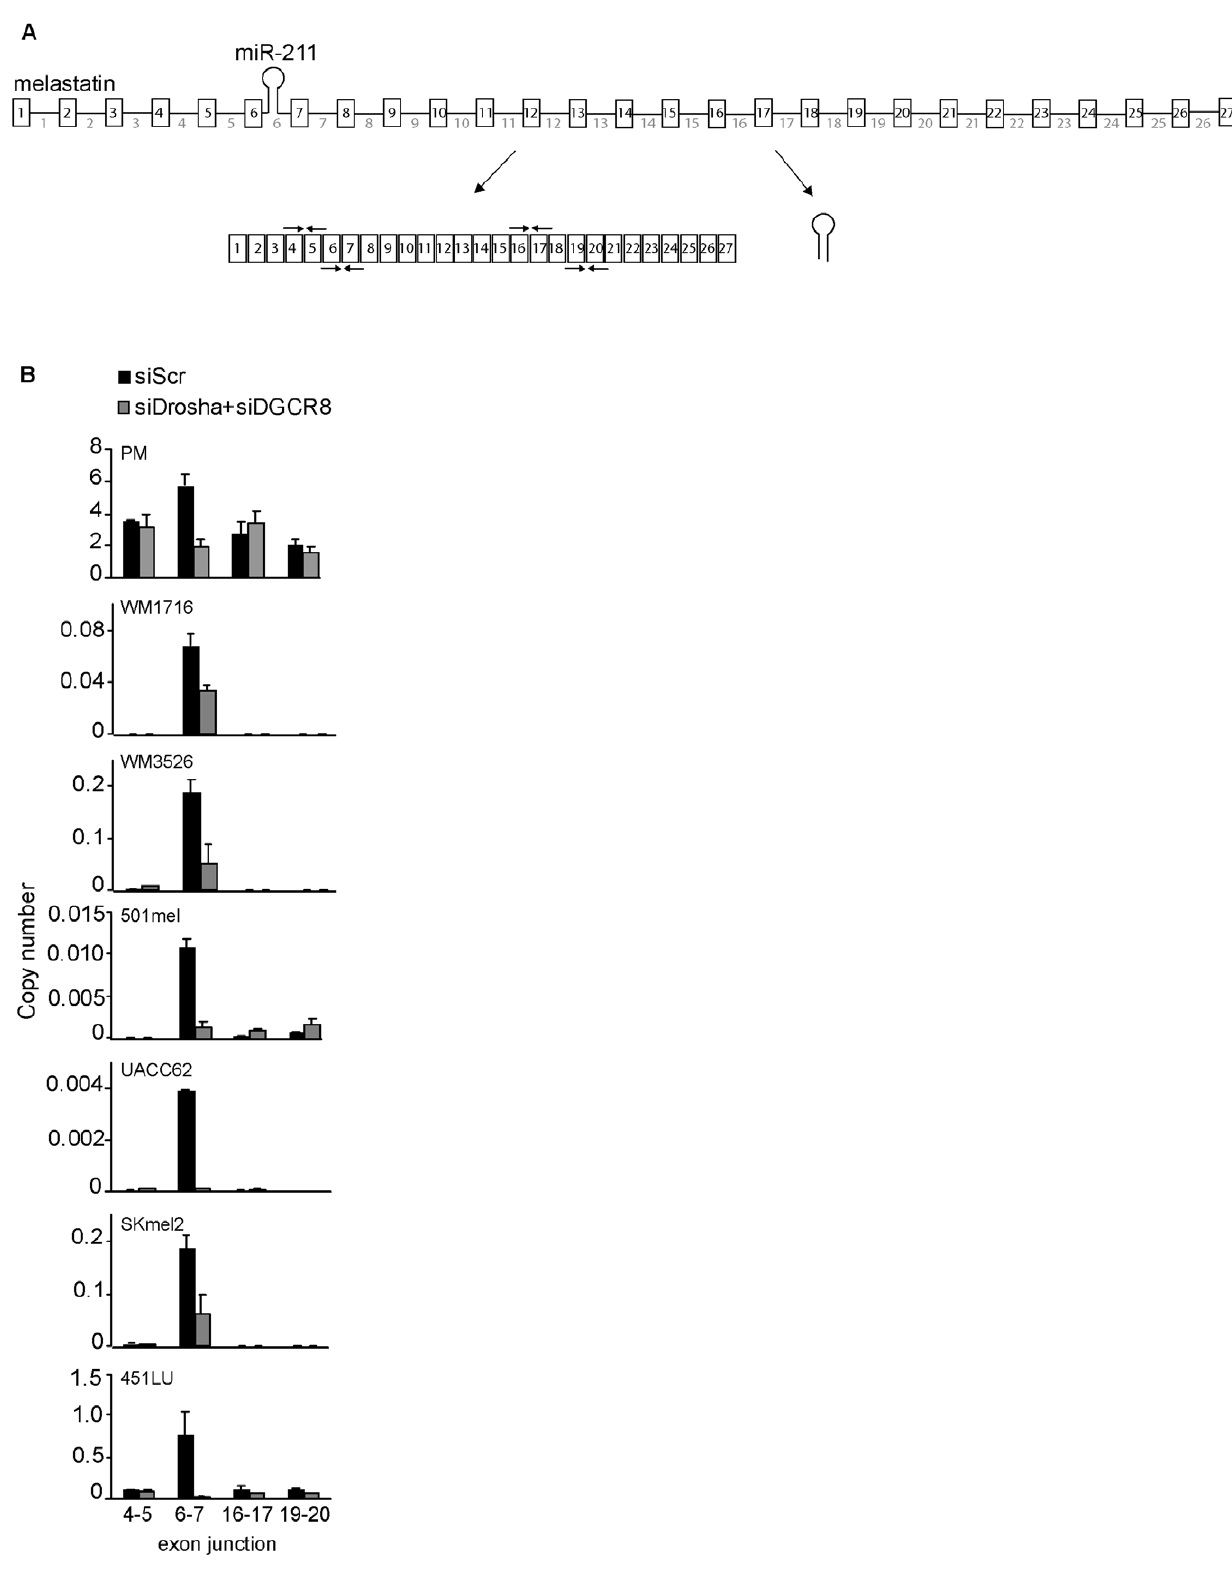
Figure 1. Microprocessor-dependent increases in melastatin exon 6–exon 7 junctions. (A) A schematic representation of melastatin primary transcript (consisting of 27 exons and 26 introns) producing both miR-211 from intron 6 and spliced melastatin mRNA. Arrow pairs represent qRT-PCR primers used to detect spliced exon-exon junctions. (B) miR-211-containing intron 6 of melastatin is preferentially spliced in primary melanocytes (PM), melanoma patient samples (WM1716 and WM3526), and melanoma cell lines (501mel, UACC62, SKmel2, and 451LU) in a Microprocessor-dependent manner. Relative copy numbers of indicated spliced exon-exon junctions, based on standard curves produced using cloned melastatin cDNA, were determined by qRT-PCR and normalized to Actin before and after Drosha and DGCR8 knockdowns. doi:10.1371/journal.pgen.1002330.g001 PLoS Genetics |